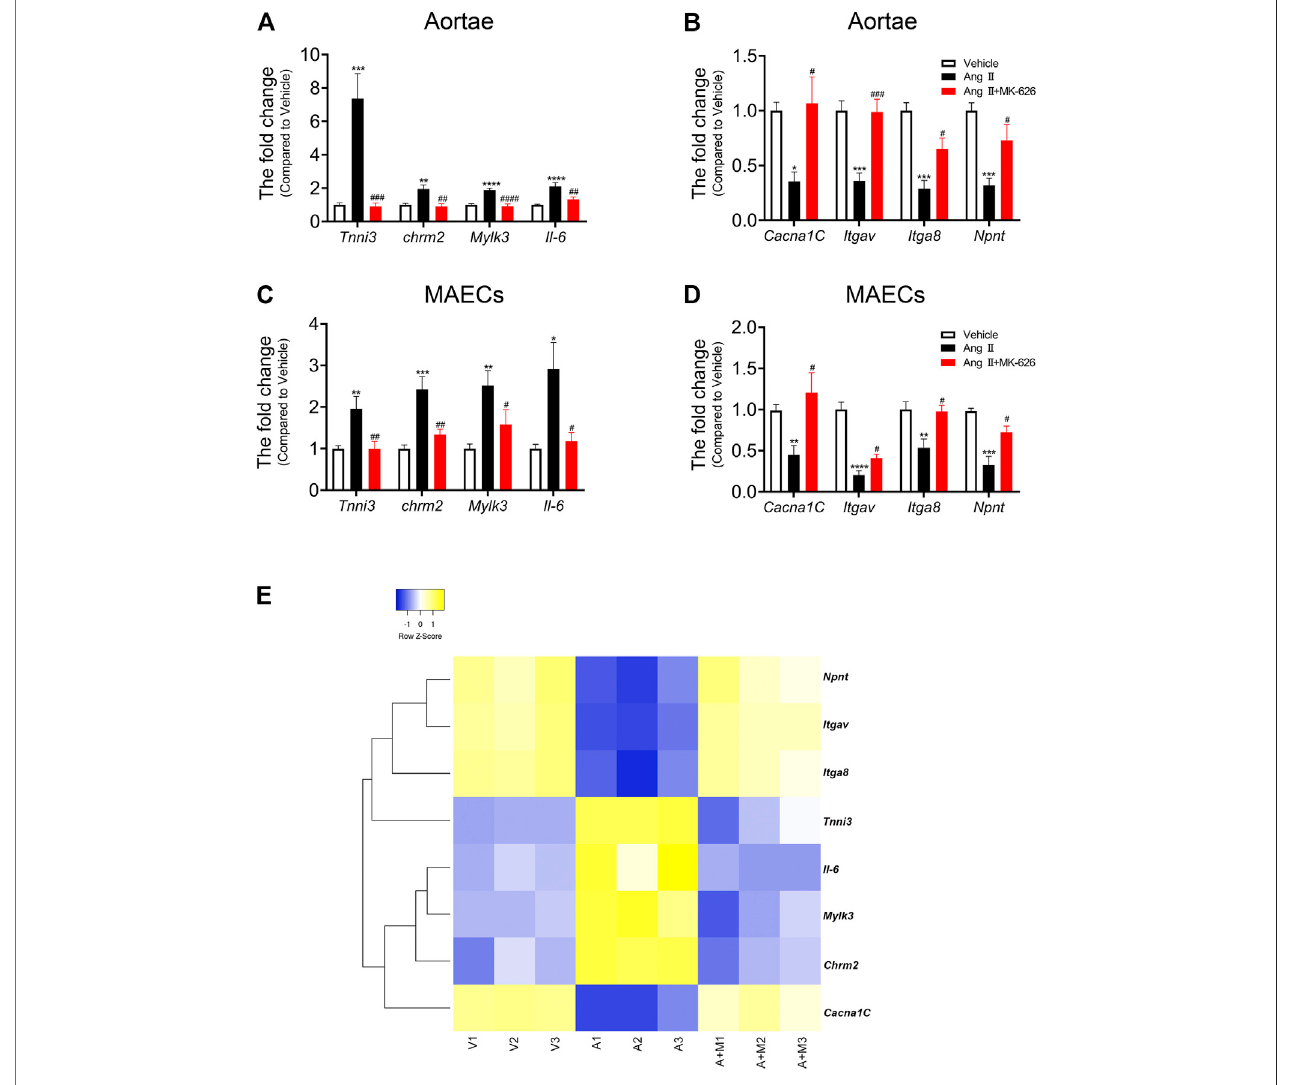
FIGURE 5 | mRNA veri fi cation and heatmap analysis. qRT-PCR validated the expression of eight candidate mRNAs in the aortae (A – B) and MAECs (C – D) . (E) Heatmapfor eight candidate mRNAs.* p < 0.05, ** p < 0.01, *** p < 0.001, **** p < 0.0001 vs Vehicle; # p < 0.05, ## p < 0.01, ### p < 0.001, #### p < 0.0001 vs Ang Ⅱ . Dataare expressed as mean ± SEM ( n (cid:1) 6 – 9 for aortae, n (cid:1) 4 – 6 for endothelial cells). V, Vehicle; A, Ang Ⅱ ; A + M, Ang Ⅱ + MK-626; MAECs, mouse aortic endothelial cells.